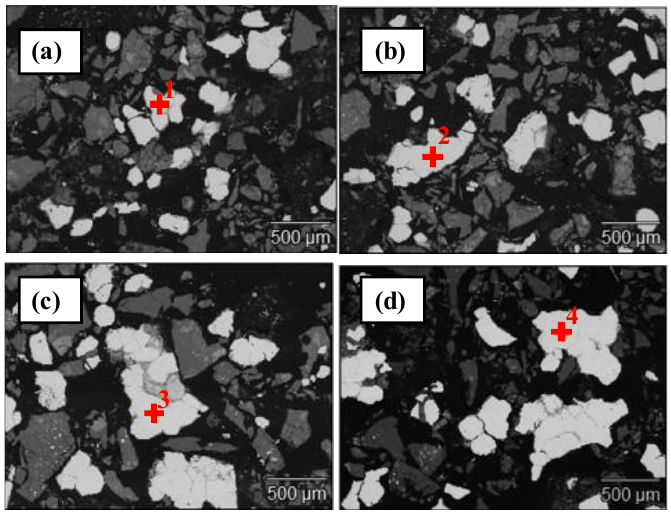
Figure 13. SEM images of ferronickel particles from different reduction time co-reduction products: